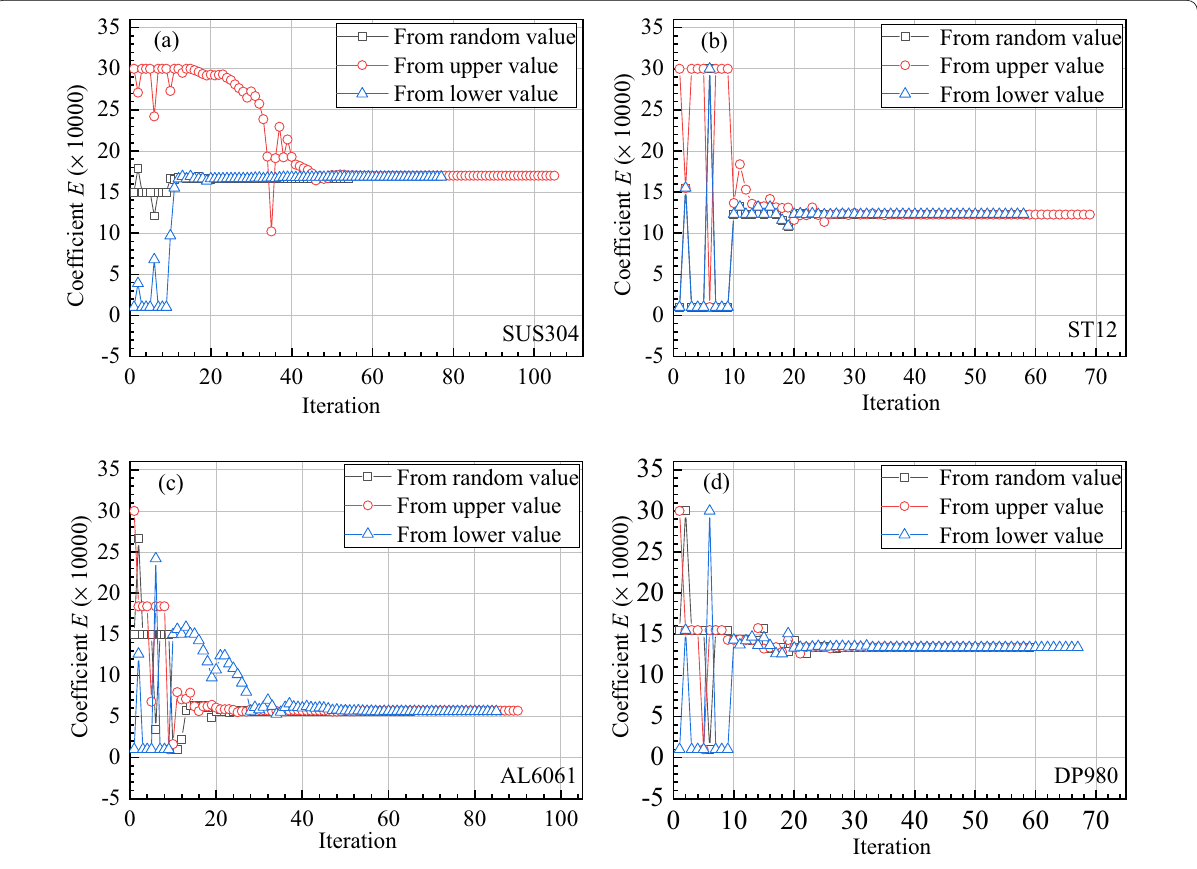
Figure 16 The learning processes of elastic modulus: a SUS304; b ST12; c AL6061; d